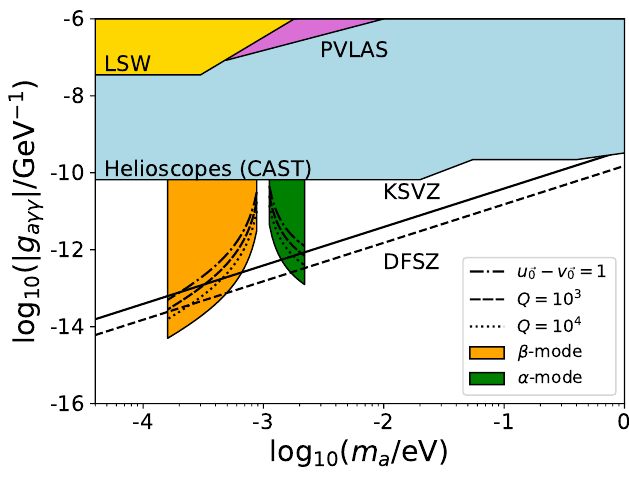
Figure 1 . Sensitivity of the magnon to the ALP DM in the m a vs. g aγγ plane. The orange (green) region corresponds to the sensitivity of the β -mode ( α -mode) with u the dot-dashed, dashed, and dotted lines in each region show the sensitivities of the same setup but with u = 1 , Q = 10 3 , and Q = 10 4 , respectively. We postulate the target volume V = (10 cm) ~ 0 − v ~ 0